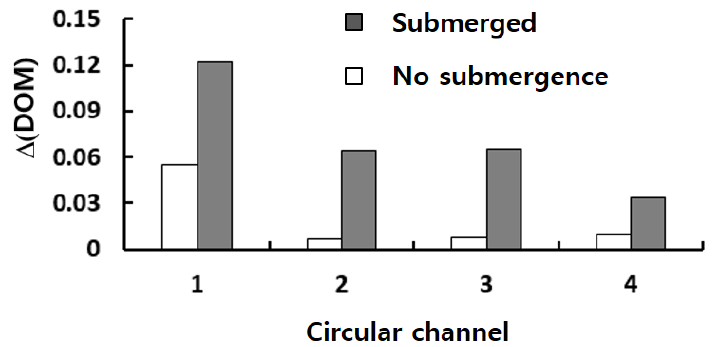
Figure 10. Comparison of the DOM increment in each circular channel for Re = 10.